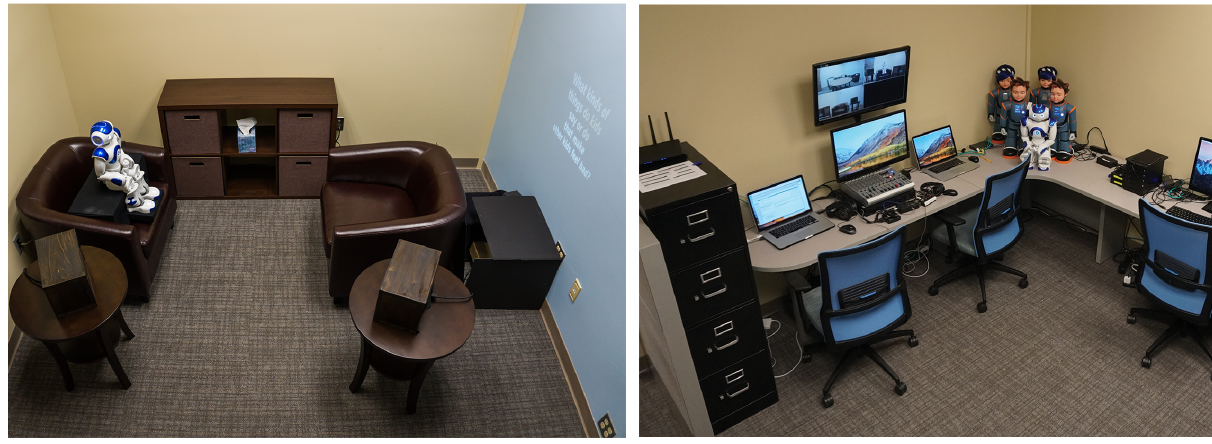
Figure 3: Left: The interview room with a Nao robot sitting in the interviewer chair and sample teleprompter projection visible on the wall behind the participant’s chair. Right: The study control room where two researchers collaboratively guide study sessions.